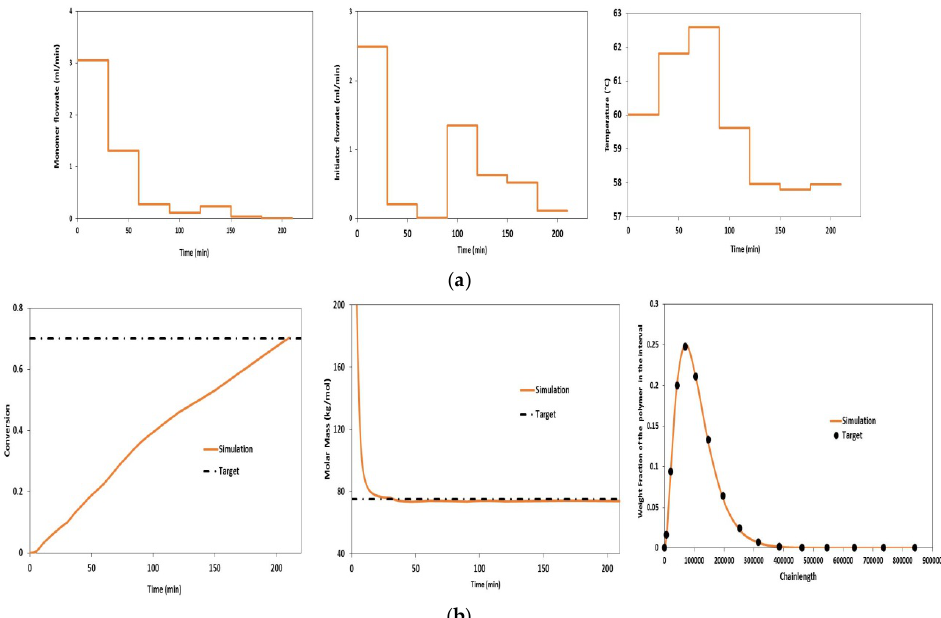
Figure 10. Simulation results of the optimal trajectories considering time in the objective function: ( a ) Input (manipulated) variables; ( b ) Controlled variables (targets).